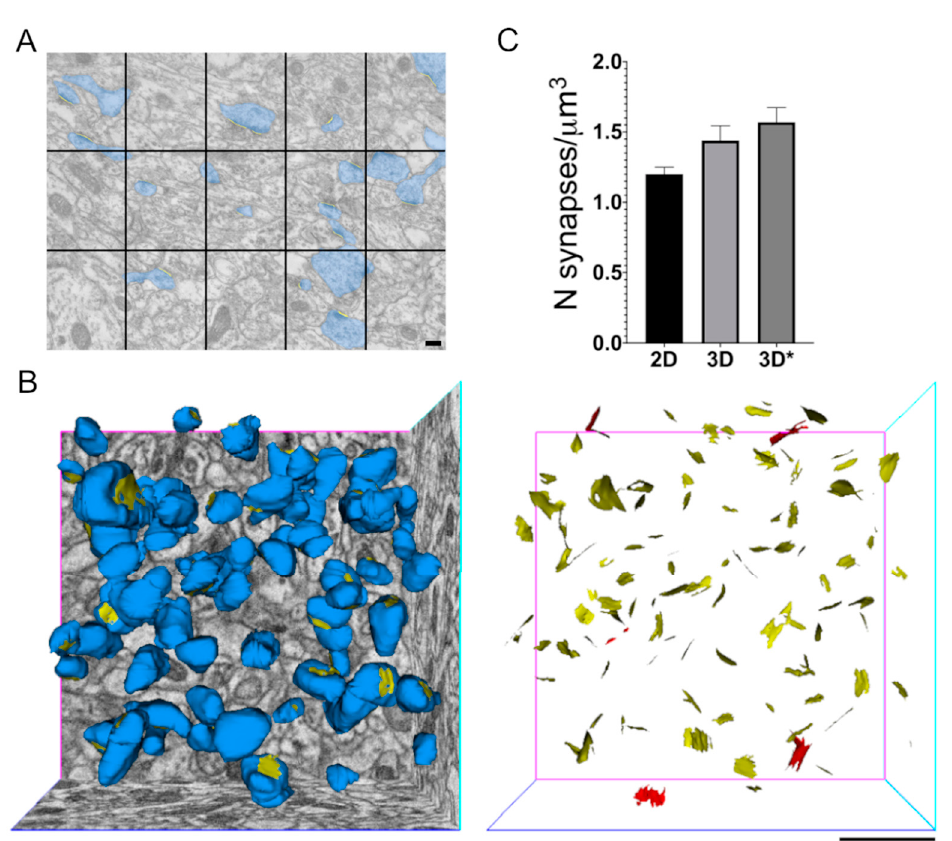
Figure 2. Effects of the type of sample, imaging and strategy adopted on synapse density evaluation. ( A ) Representative TEM micrograph of the mouse CA1 hippocampus where a number of excitatory synapses (highlighted in blue) can be easy detected and counted by the superimposition of a stereological grid, according to the size-frequency method (see Materials and Methods). The PSDs counted are highlighted in yellow (scale bar = 200 nm). ( B ) Reconstructed spine heads (blue) and SASs (yellow) in a volume of CA1 hippocampal neuropil (left); and isolated SASs on dendritic spines (yellow) and SASs on the dendritic shaft (red) (right) (scale bar = 1 µ m). ( C ) Evaluation of excitatory synapse density comparing the results obtained with stereology on 2D EM projections and count on 3D reconstructed volumes. The histogram reports the mean number of synapses/ µ m 3 ± standard error of the mean (S.E.M.) for each type of analysis and both count of only dendritic spine SASs (3D) and these, together with the dendritic shaft SASs (3D*) are reported.